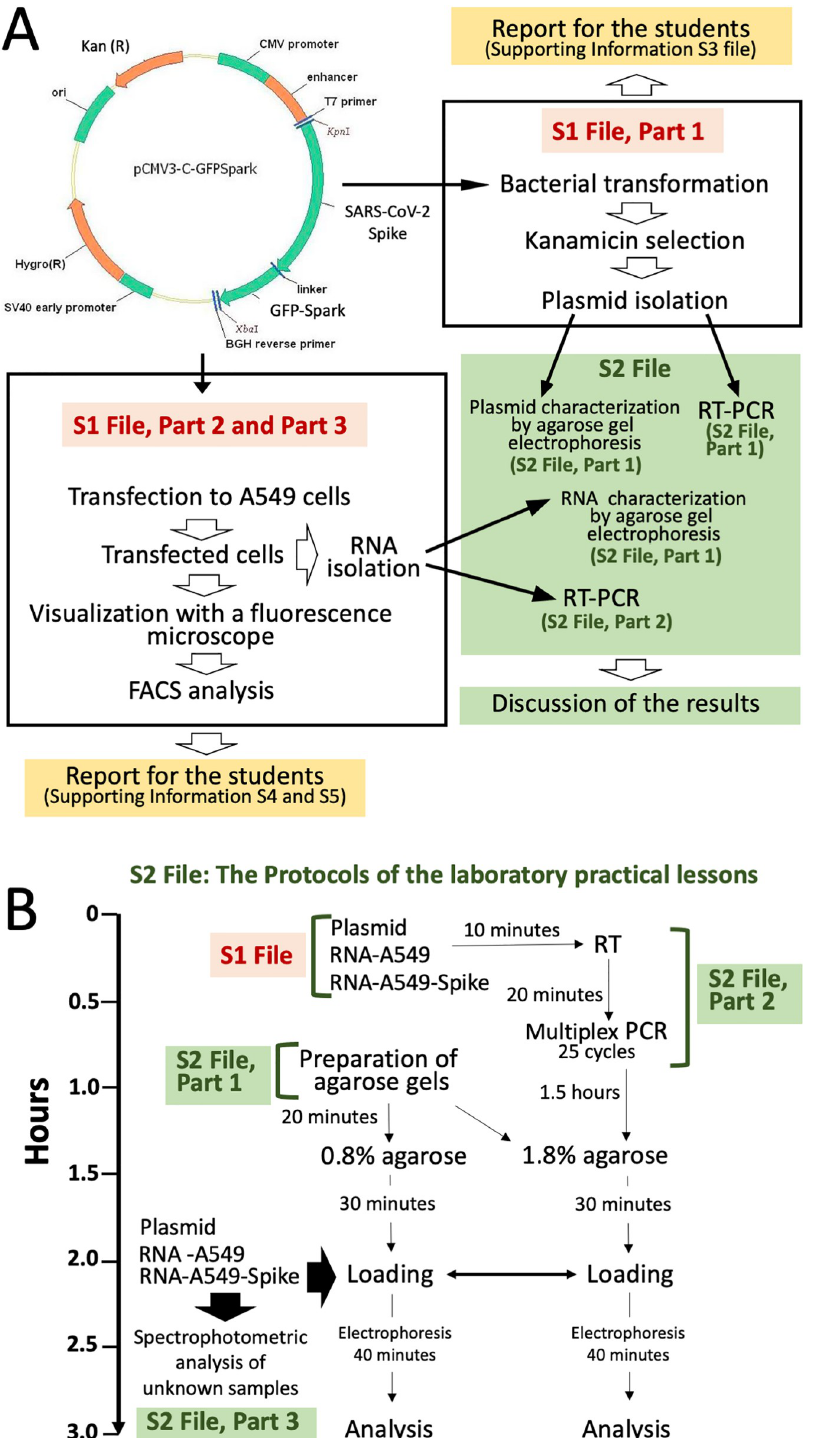
Fig 1. Timing of the laboratory practice. A. Preliminary activity conducted in the absence of students. B. Timing of the practical laboratory showing all the activities to be followed by the students. The protocols are described in S1 and S2 Files. The methodologies are also described in S3–S5